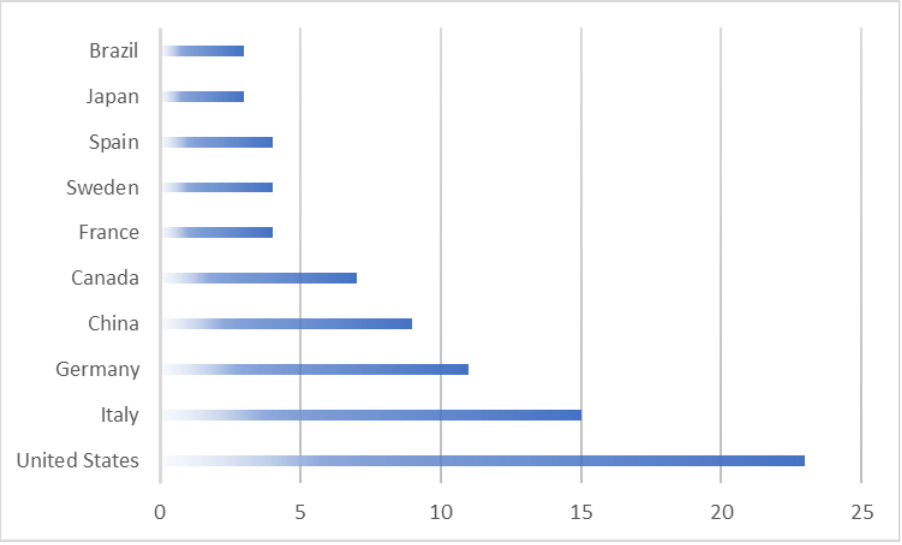
Figure 7. Number of national publications by country of authors ’ origin. Source: own processing. Table 1. Most cited publications and their authors by number of citations. Source: own